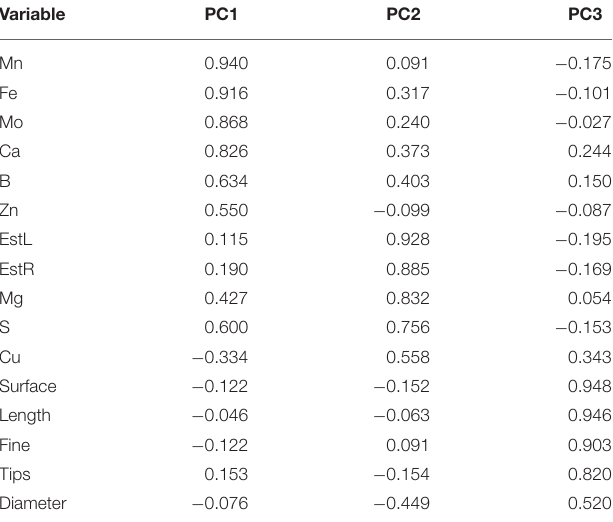
TABLE 7 | Loadings values of some morphometric and chemical variables on the axes identified by principal components analysis for control (untreated) maize plants and plants supplied for 48h with extracts obtained from the seaweeds Laminaria (A) and Ascophyllum nodosum spp.